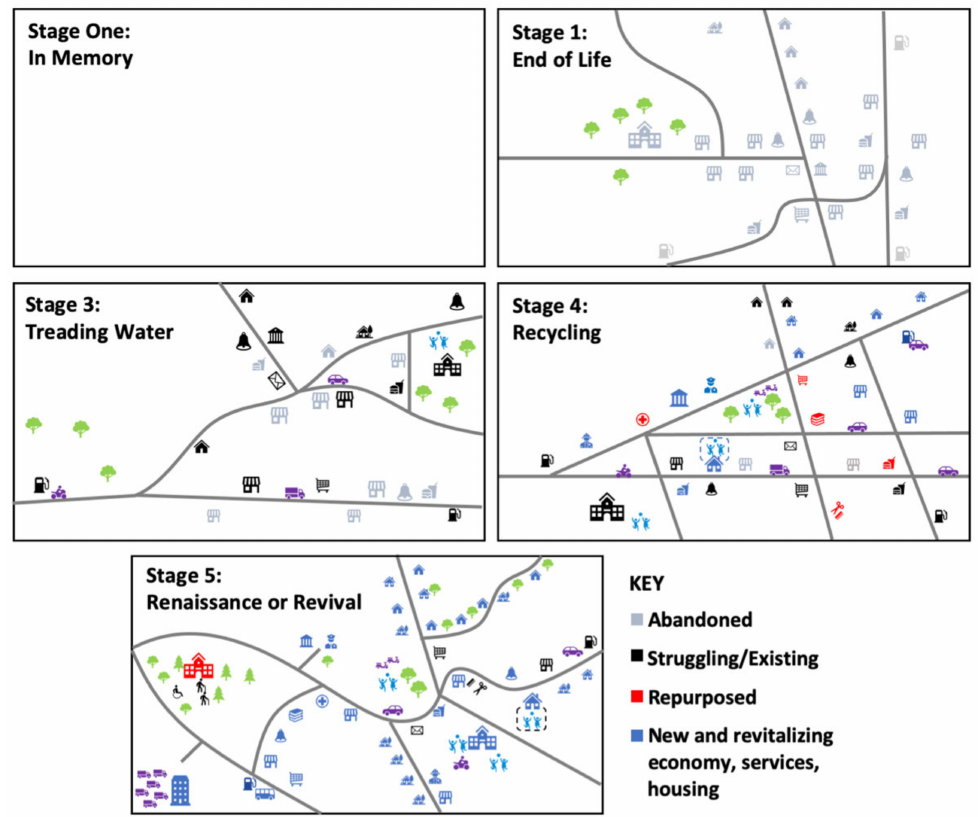
Figure 2. Visual typology of rural devolution and evolution. Stage 1: In Memory. Empty